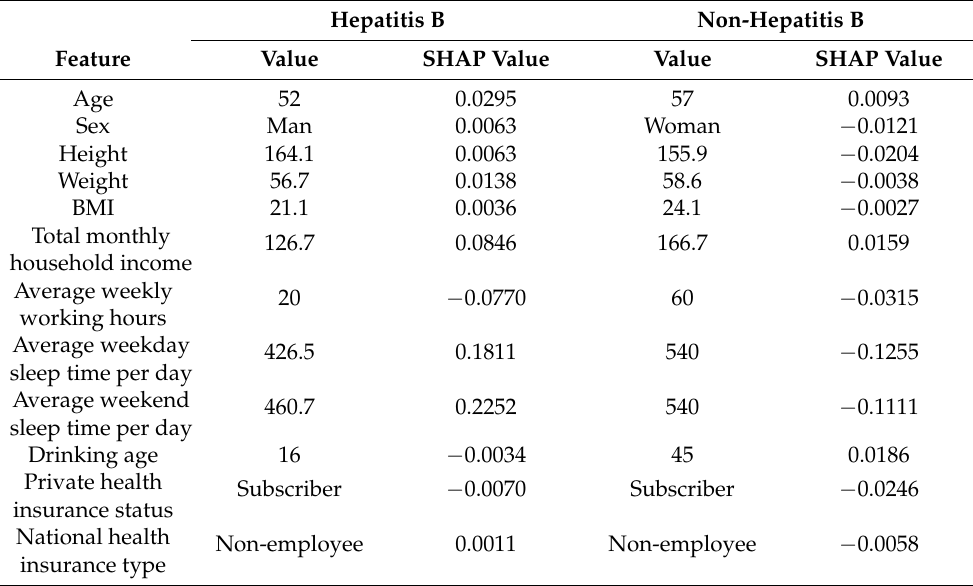
Table 15. Example of SHAP analysis for observations of the hepatitis B risk association model. Hepatitis